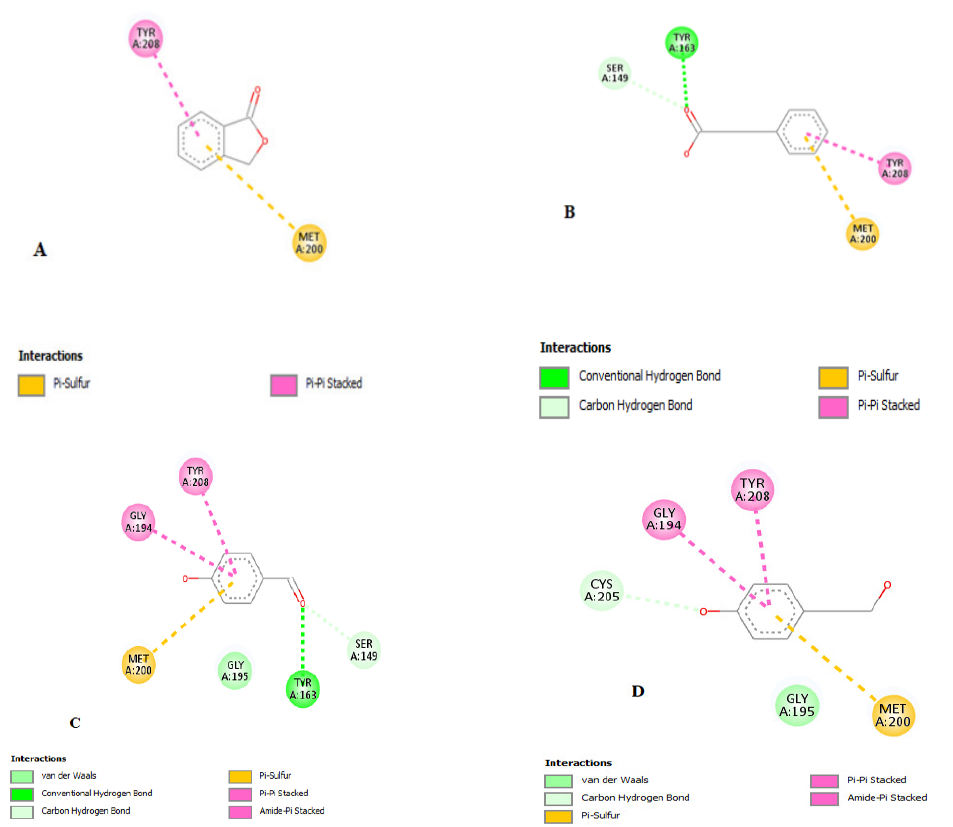
Figure 7. 2D structures of 3THNR receptor and the studied ligands; (A): Phthalide; (B): Phenylethyl alcohol; (C): p-Hydroxybenzaldehyde; (D): Tyrosol